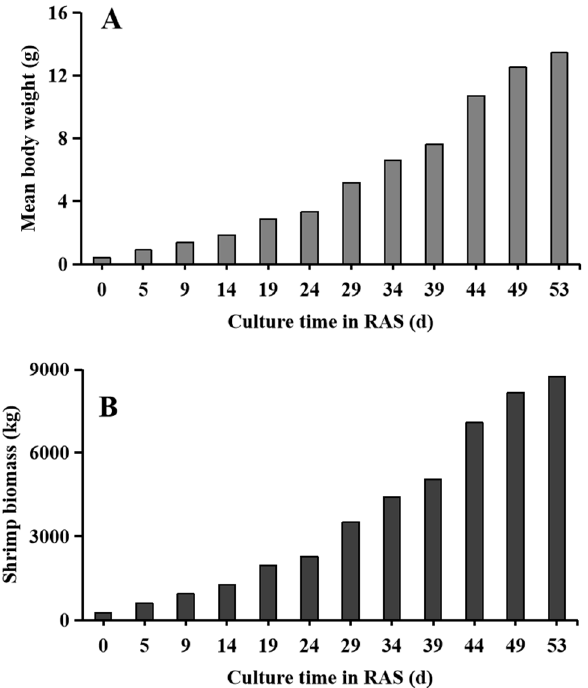
Figure 3. Changes in average body weight ( A ) and biomass ( B ) of whiteleg shrimp, Litopenaeus vannamei , during the recirculating aquaculture period.